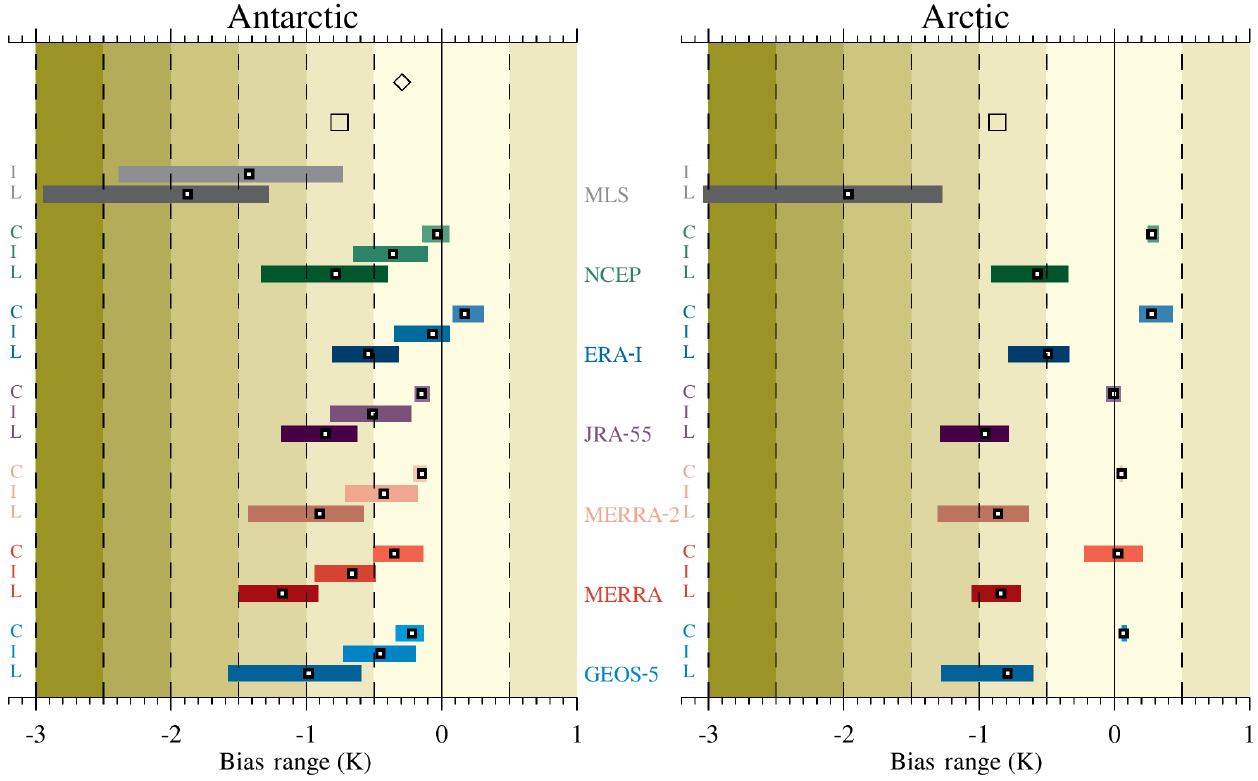
Figure 20. Temperature bias ranges of the reanalyses, and MLS, relative to the LIQ (L) and ICE (I) equilibrium references, and COSMIC (C), for Antarctic and Arctic winters 2008–2013, poleward of 60 ◦ , and for pressure levels from 68 to 21hPa, derived from the data in Figs. 16 and 17. The bias ranges are obtained from the extrema of the yearly mean bias values over 68–21hPa weighted by the yearly standard deviations. Each horizontal colored bar indicates the range of the minimum to maximum bias for MLS and the particular reanalysis scheme given in the legend. White squares with black border indicate the mean bias over 68–21hPa. Open square (diamond) symbols indicate the mean values of (cid:49)T LIQ − (cid:49)T COSMIC ( (cid:49)T ICE − (cid:49)T COSMIC ) over 68–21hPa, obtained from Fig. 19. There are insufficient statistics for a reliable comparison with the ICE reference in the Arctic. Note that MLS has not been compared directly to COSMIC. Background shading indicates 0.5K increments in the bias